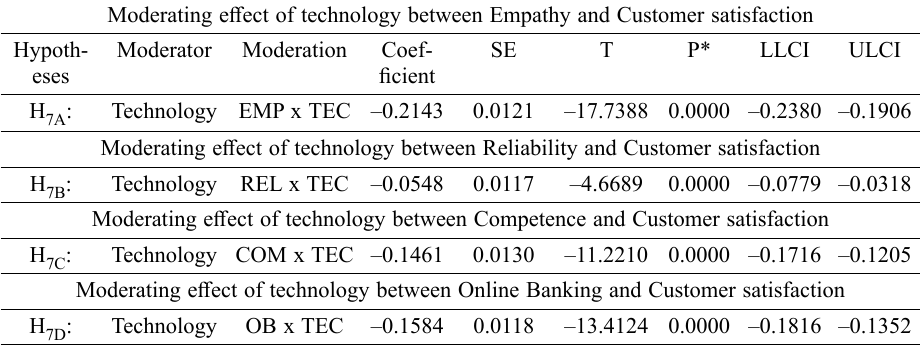
Table 8. Moderating effect of technology